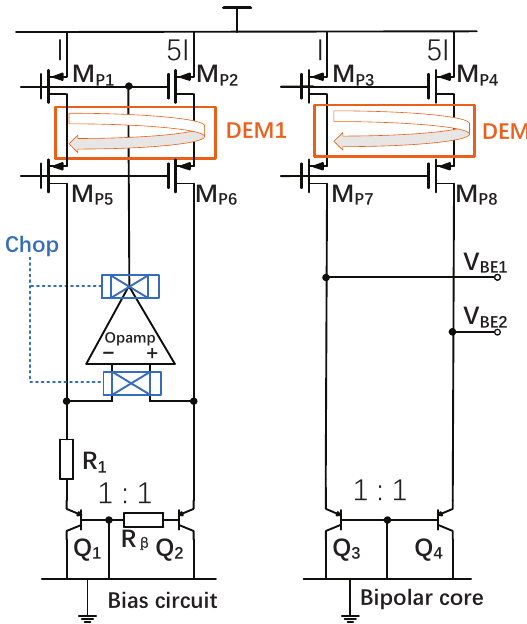
Figure 3. Circuit diagram of the sensing